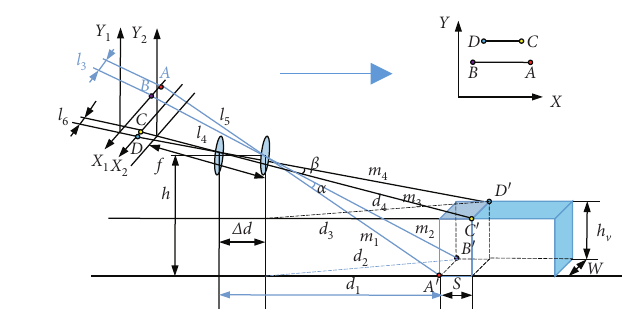
Figure 11: Schematic diagram of moving obstacle.